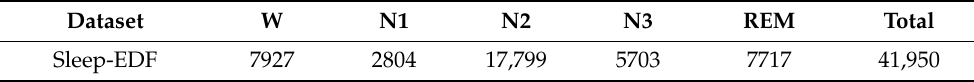
Table 1. Sample distribution of Sleep-EDF dataset. Dataset W N1 N2 N3 REM Total Sleep-EDF 7927